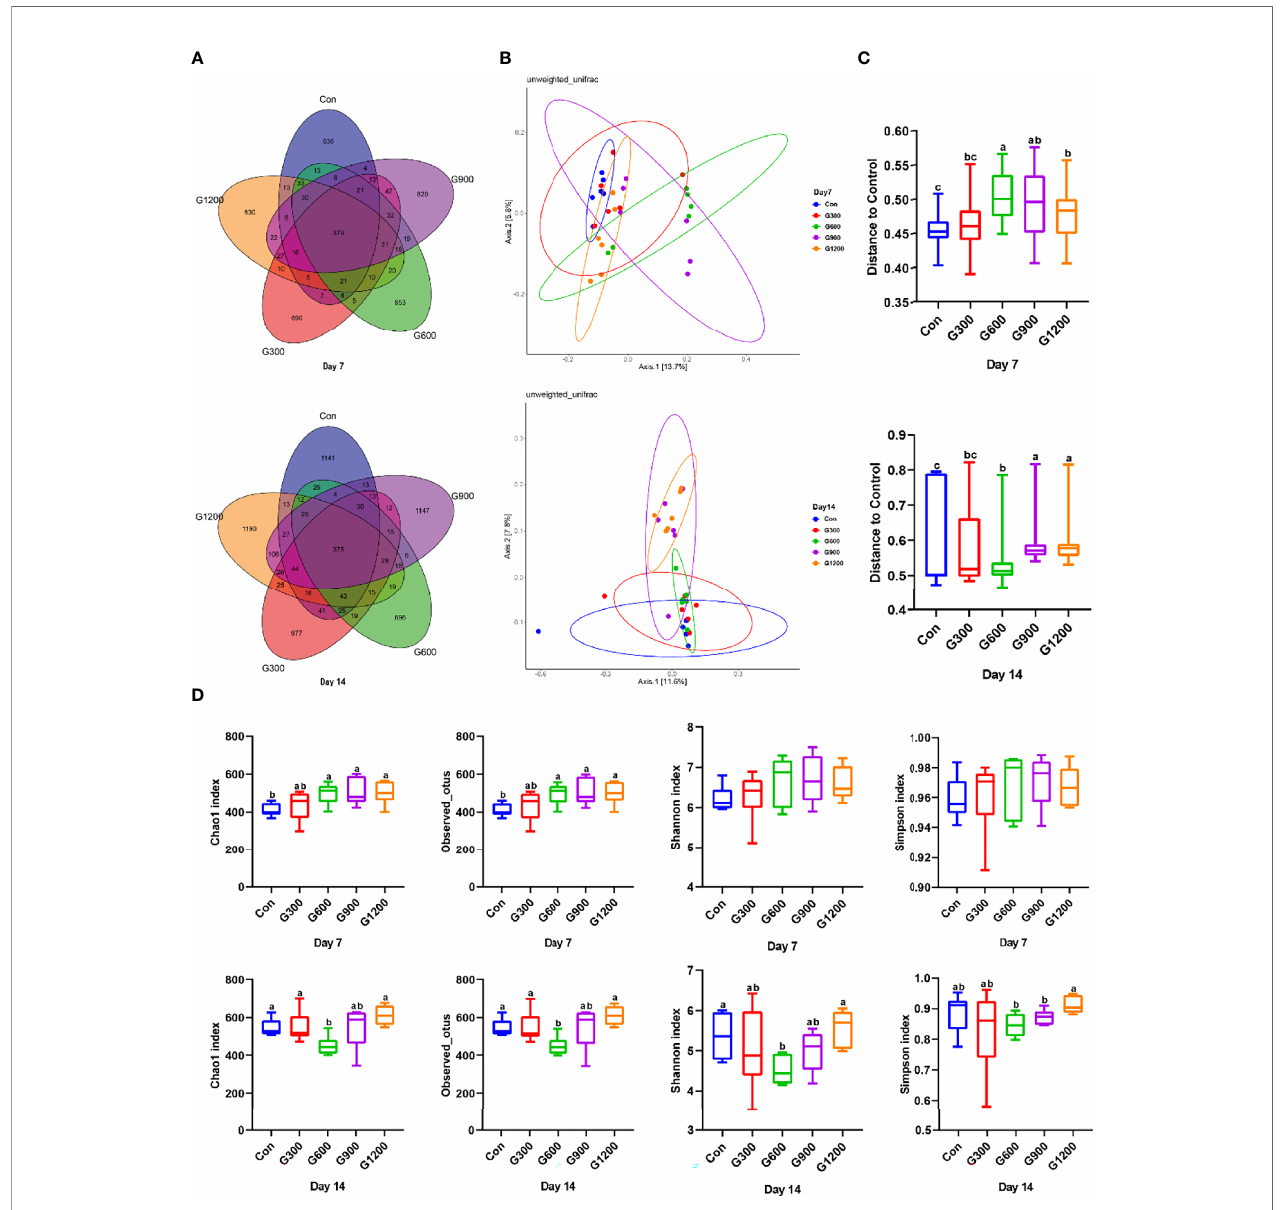
FIGURE 1 | Dietary GML altered the composition and community diversity of cecal microbiota. (A) Venn diagram between treatments on OTUs level. (B) PCoA analysis based on unweighted Unifrac distance. (C) PERMANOVA analysis based on unweighted Unifrac distance. (D) Alpha-diversity based on indices of Chao 1, Observed otus, Shannon and Simpson; different superscripts indicate signi fi cant differences according to the unpaired Wilcoxon comparison test. Con, basal diet; G300, 600, 900, and 1200, basal diets complemented with 300, 600, 900, or 1200 mg/kg